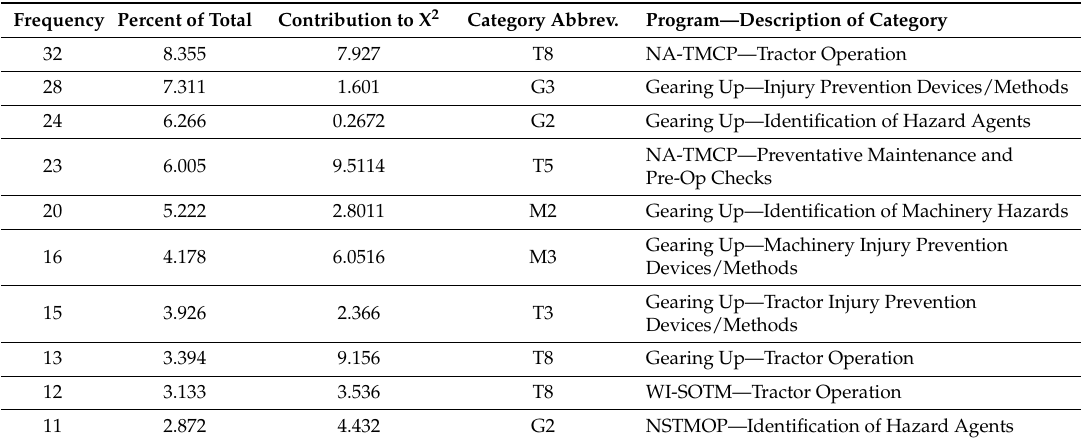
Table 6. Secondary Learning Outcomes with Highest Frequency, by